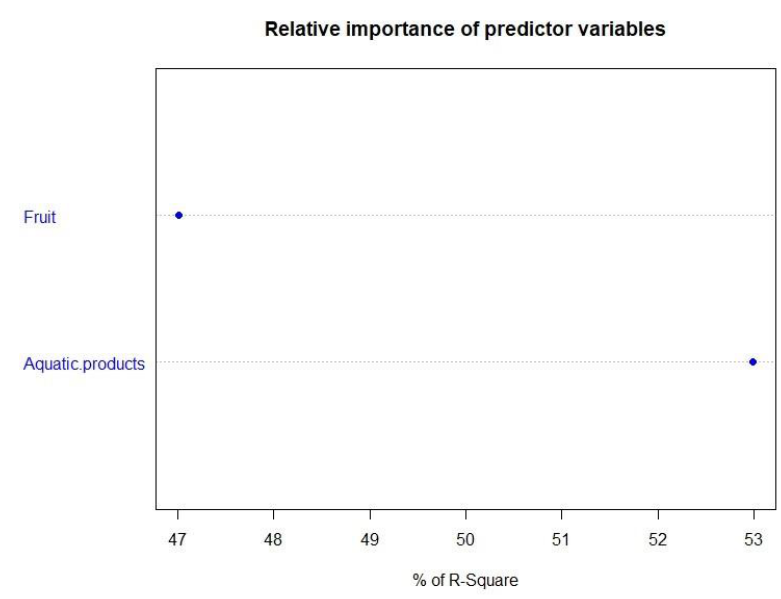
Figure 9. The relative importance of predictor variables.